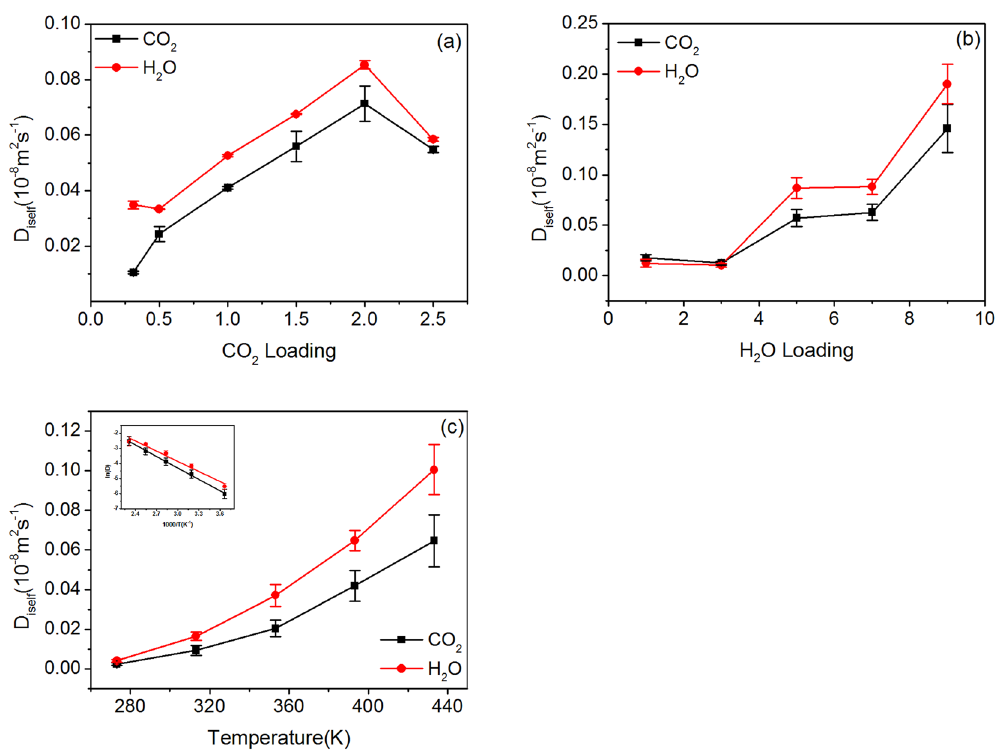
Figure 2. D iself of CO 2 and H 2 O in MMT with different systems: ( a ) CO 2 loading; ( b ) H 2 O loading; ( c ) temperature. Inset of ( c ) shows Arrhenius plot of SDC versus